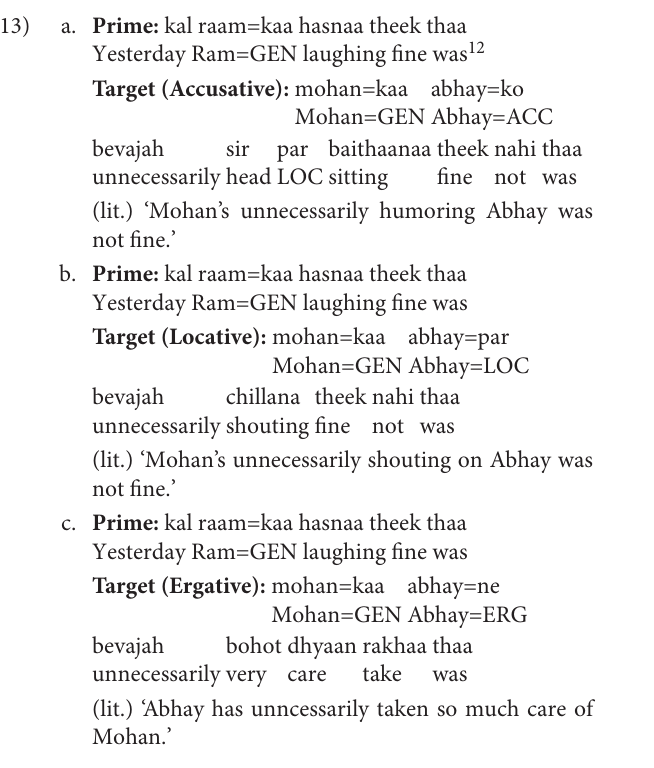
TABLE 4 | Predictions of the Residual activation theory (RA) and the Prime-Target Structural Compatibility Hypothesis (PTSC) for the syntactic priming effect in the three conditions for Experiment 2.